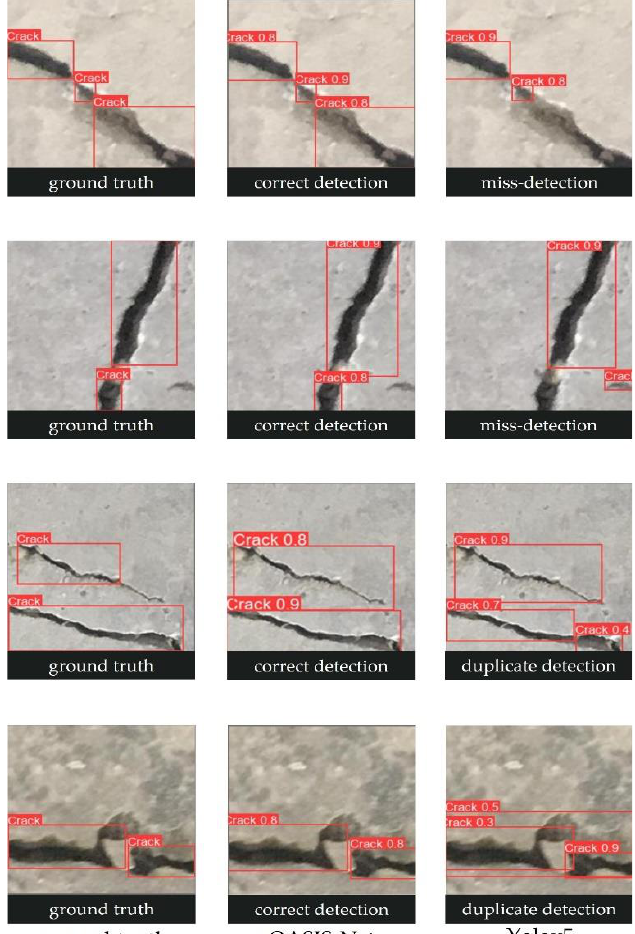
Figure 15. Visual comparison of crack detection results.